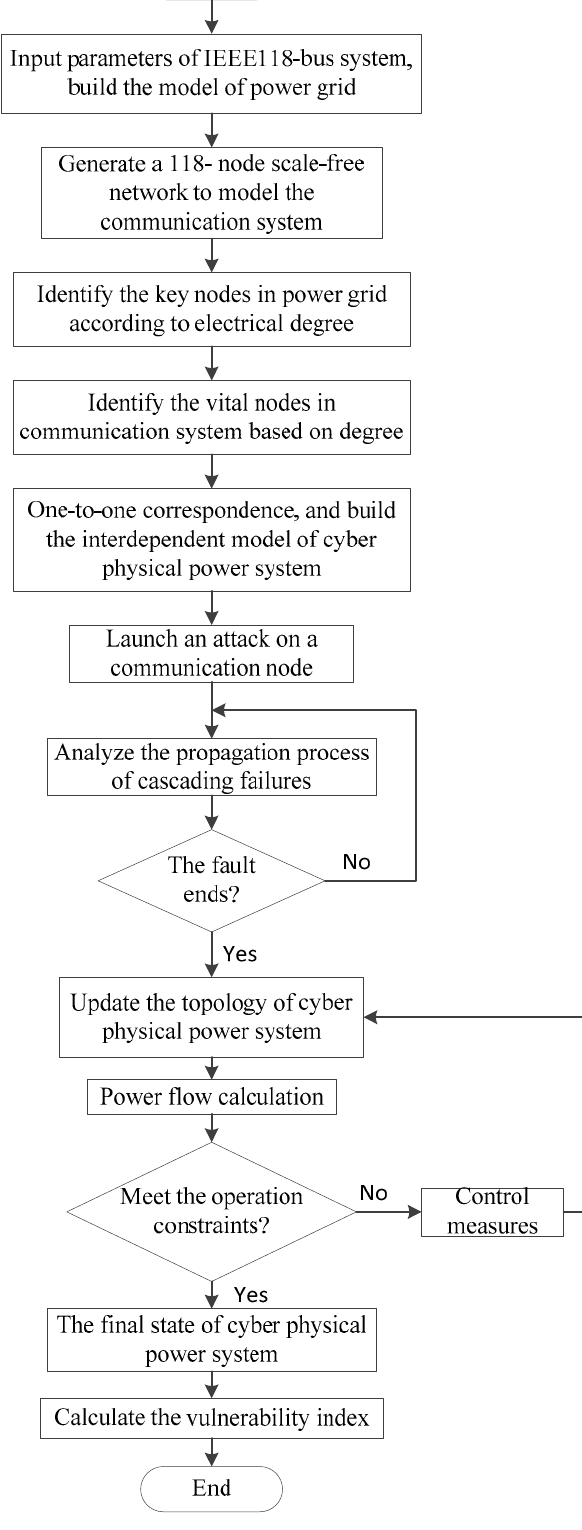
Figure 7. Simulation flowchart.